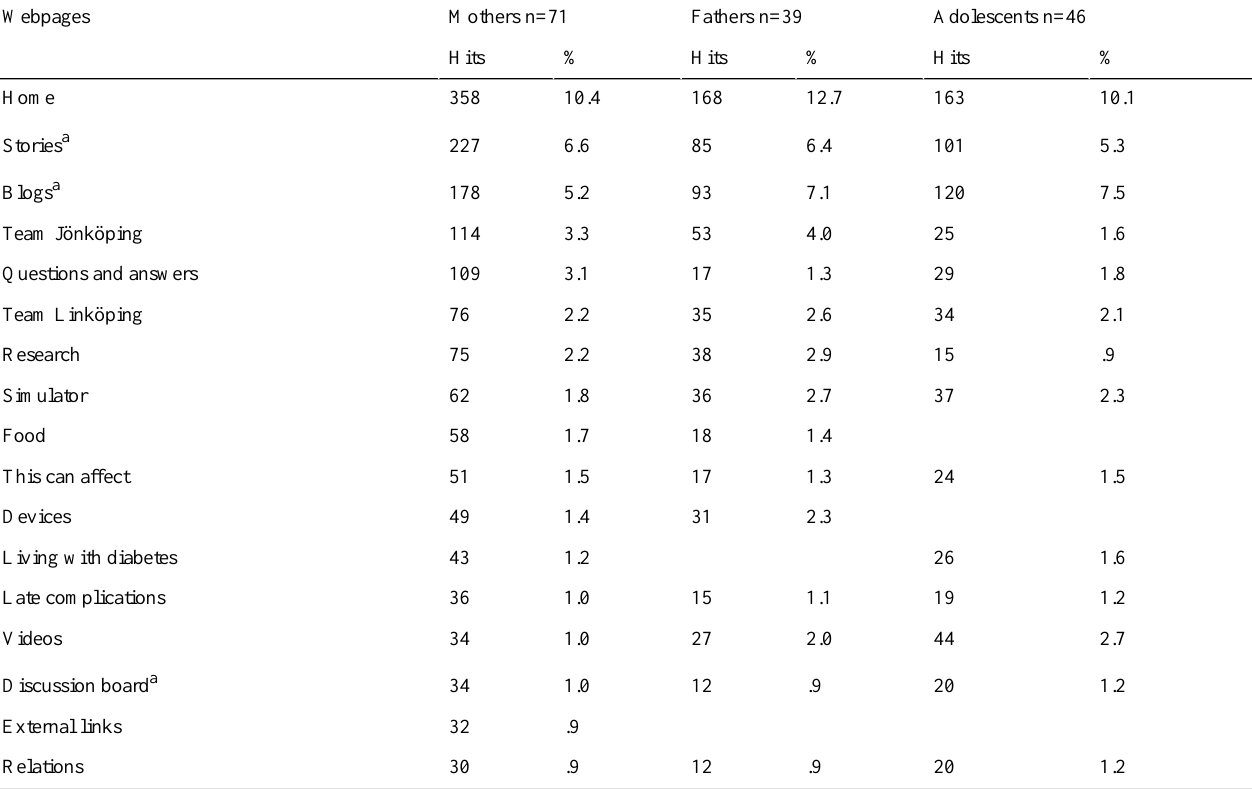
Table 2. Page hits on frequently visited pages, intervention group study year 1.